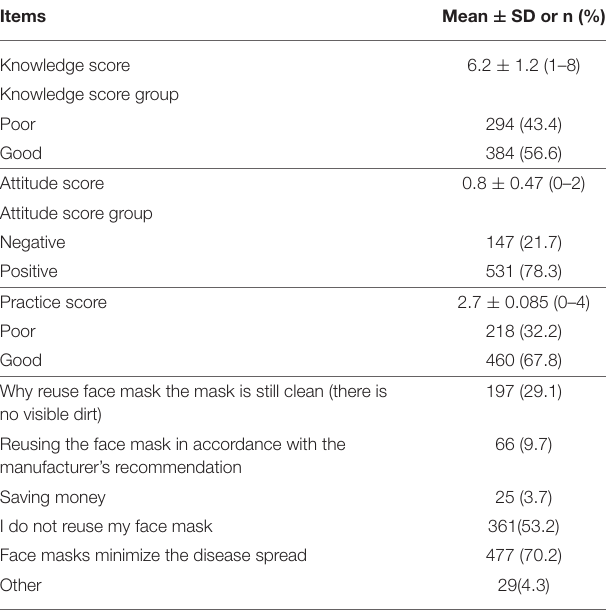
TABLE 2 | Knowledge, attitudes, and practices of 678 respondents related to face mask use and reuse.